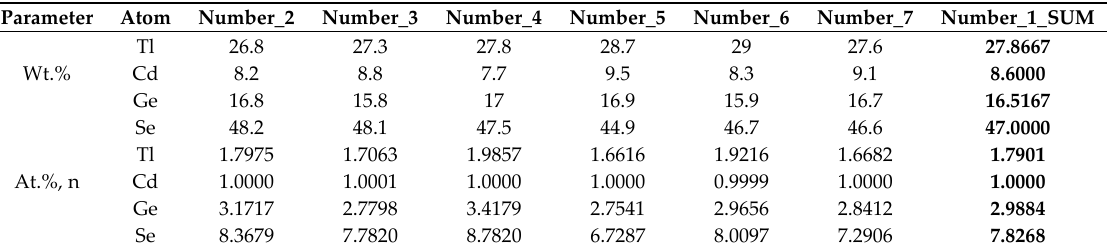
Table 2. SEM/EDS results of the Tl 2 CdGe 3 Se 8